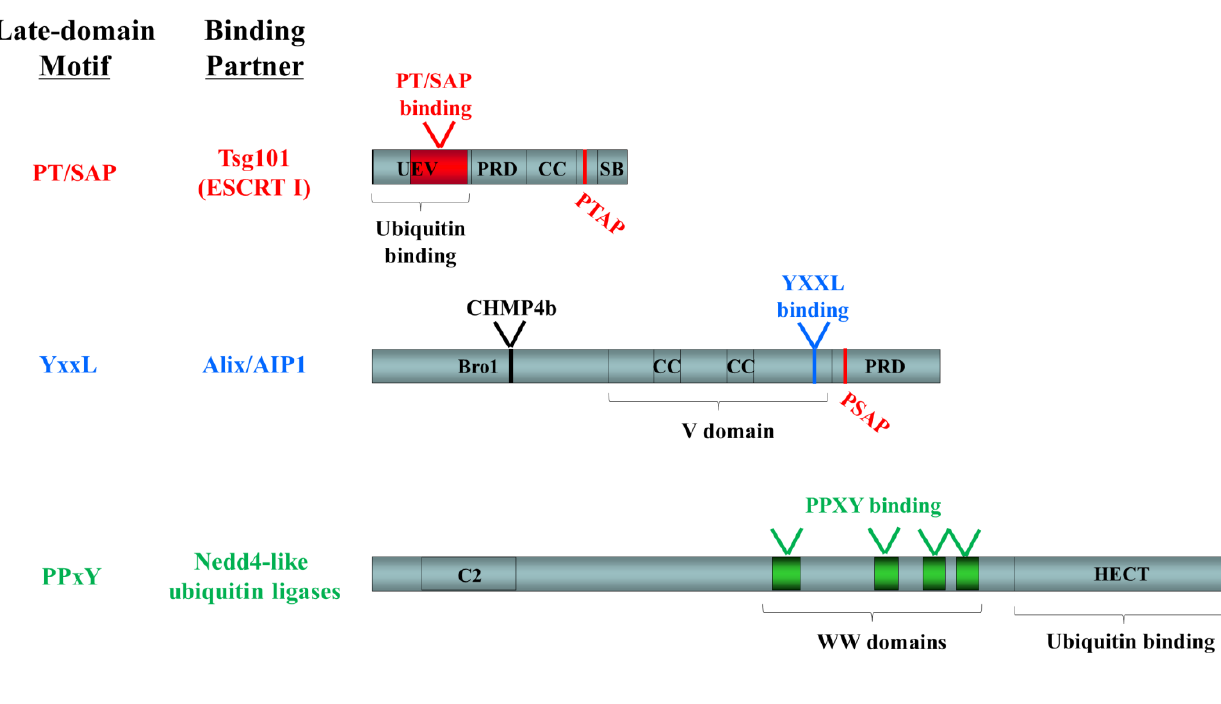
Figure 3. Functional domains in known late-domain-interacting ESCRT-pathway components. The following domains are indicated: UEV, ubiquitin E2 variant; PRD, proline-rich domain; CC, coiled-coil; SB, steadiness box; Bro1, BCK1-like resistance to osmotic shock; V, V domain; C2, conserved domain 2; WW, WW domain; HECT, homologous to the E6-AP carboxyl terminus. Late domain motifs and their binding sites are shown in color (PT/SAP, red; YxxL, blue; PPxY, green). Binding sites for other ESCRT pathway components are indicated in